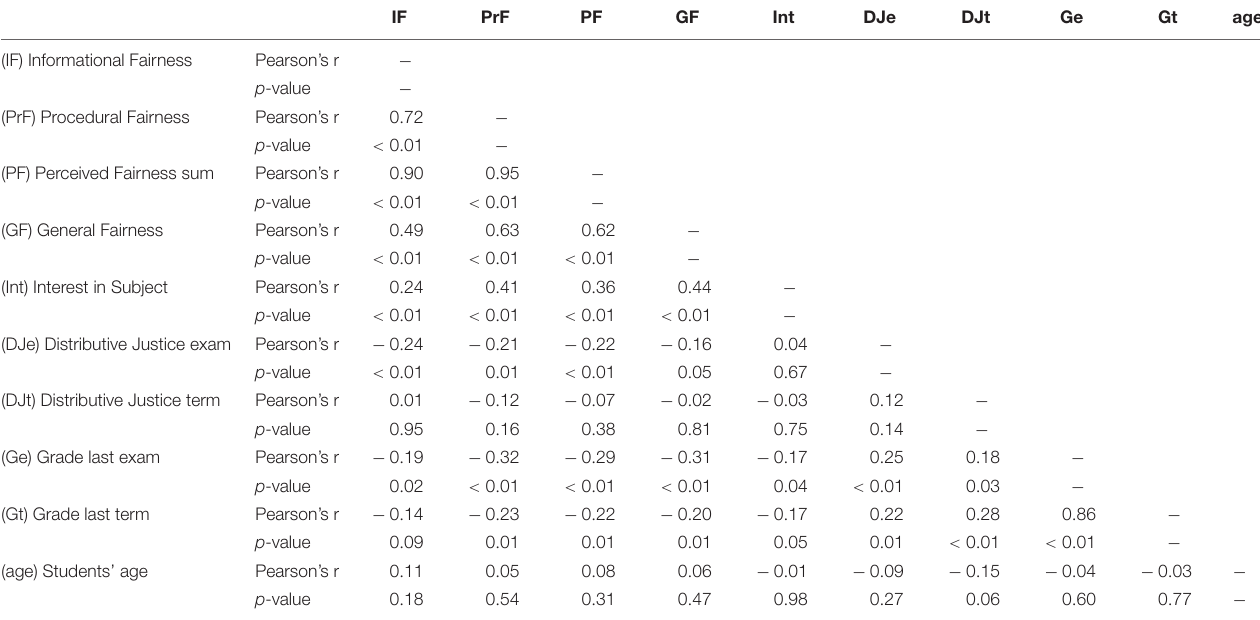
TABLE 2 | Correlations between Perceived Fairness, Distributive Justice, Interest in the Subject, and Teacher’s experience ( n = 168).